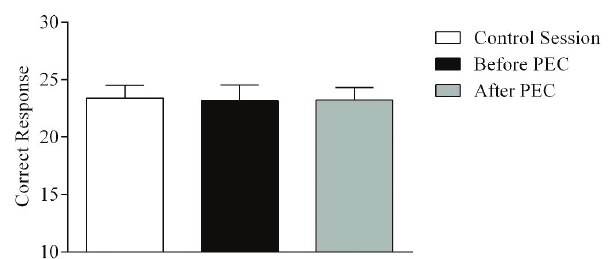
Figure 2. Results of correct response for control session (white bar), before PEC (black bar) and after PEC (gray bar). Only Stroop Test outcomes obtained before the PEC were reported.